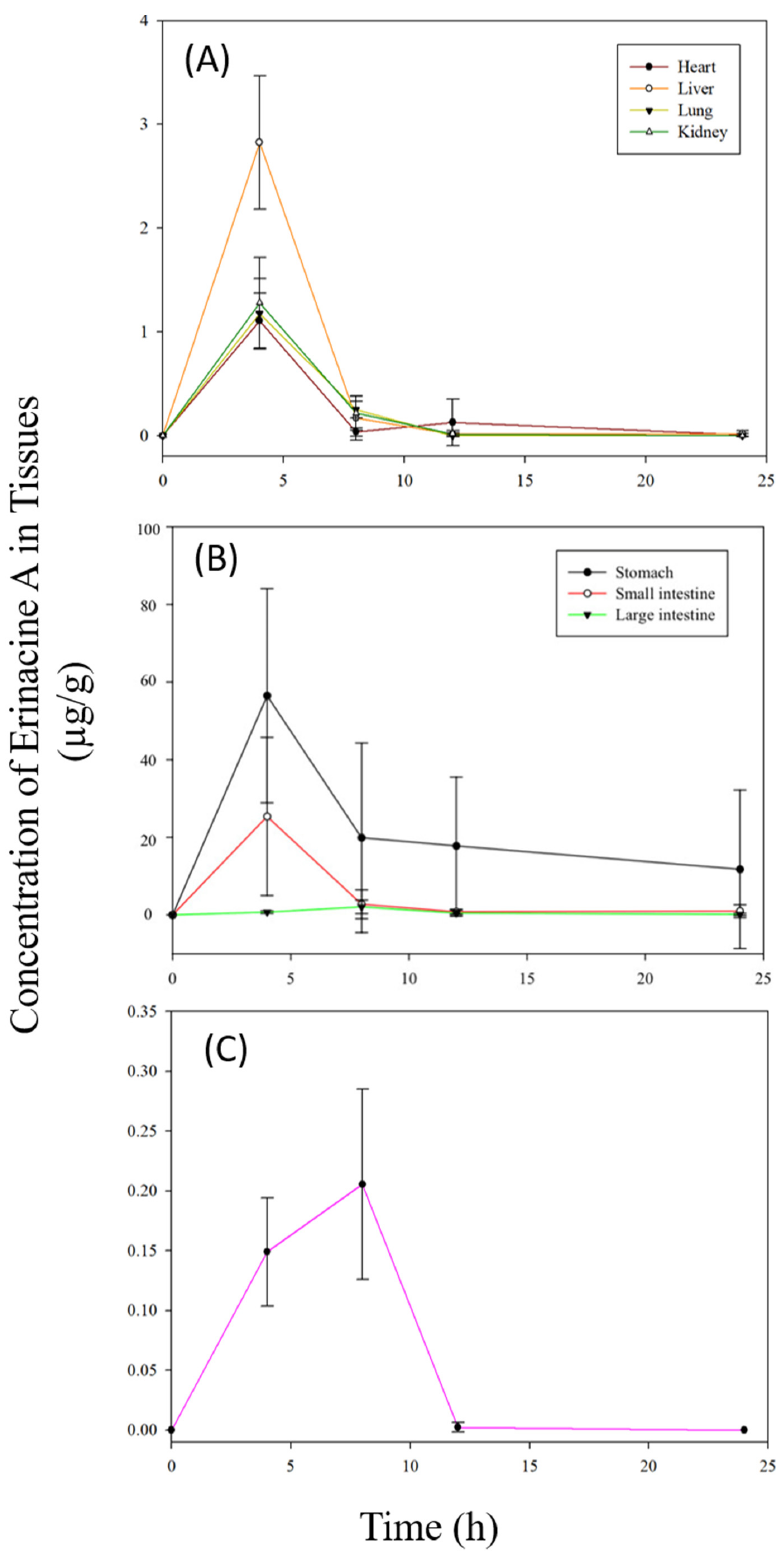
Figure 4. Mean plasma concentration–time curves of erinacine A in ( A ) stomach, small intestine, large intestine, ( B ) heart, liver, lung, kidney, and ( C ) brain of rats after oral administration of H. erinaceus mycelia extract at 2.381 g/kg BW (equivalent to 50 mg/kg BW of erinacine A). Values are means ± SD (n =